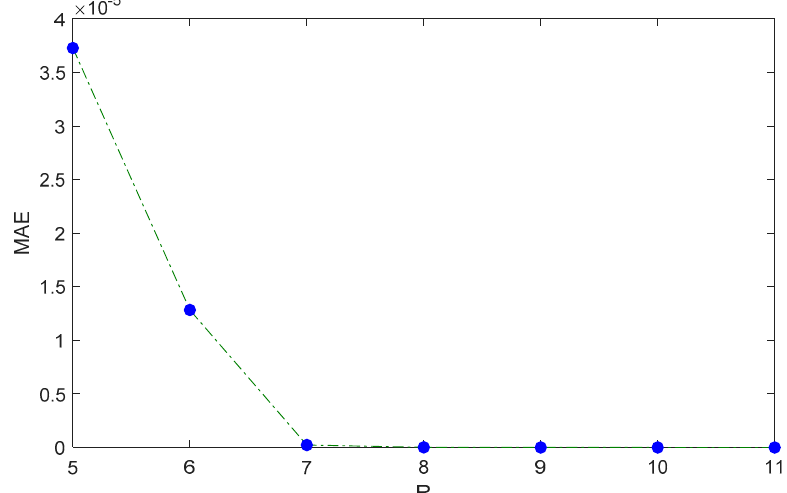
Figure 6. Plot of MAE for different values of 𝑅.